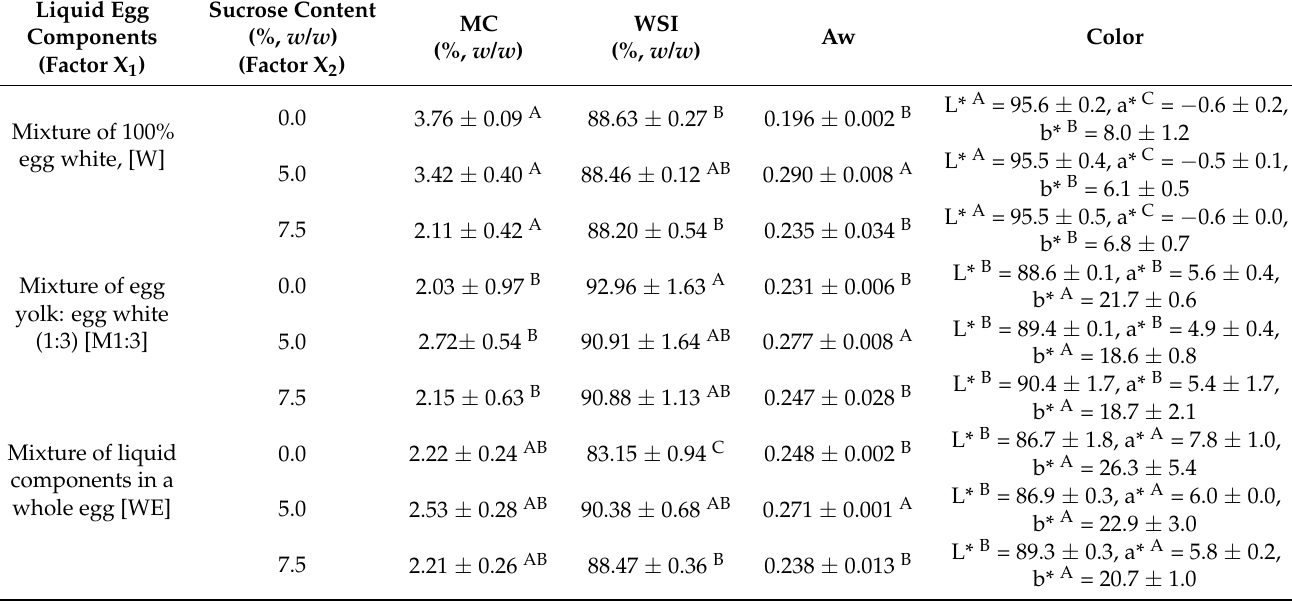
Table 3. Results of the physicochemical characteristics of the dried powders of processed egg component mixtures (mean ± standard